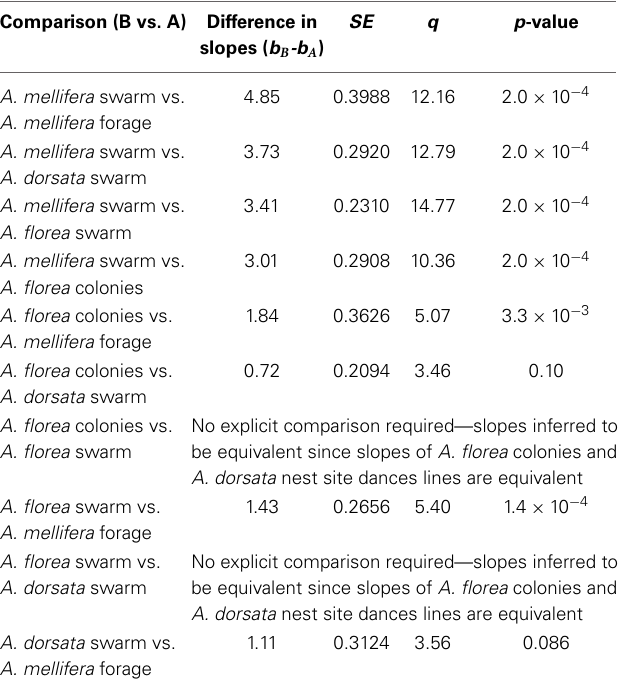
Table 1 | Linear regression statistics, angular deviation α (degrees) vs. mean waggle phase duration t (s) for our five data sets.